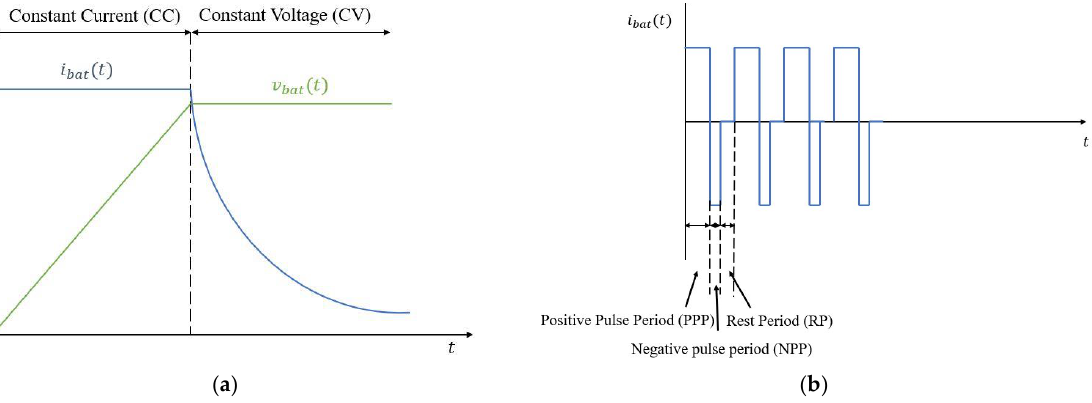
Figure 23. Charging current i bat variation in ( a ) CC-CV charging mode and ( b ) Reflex charging mode